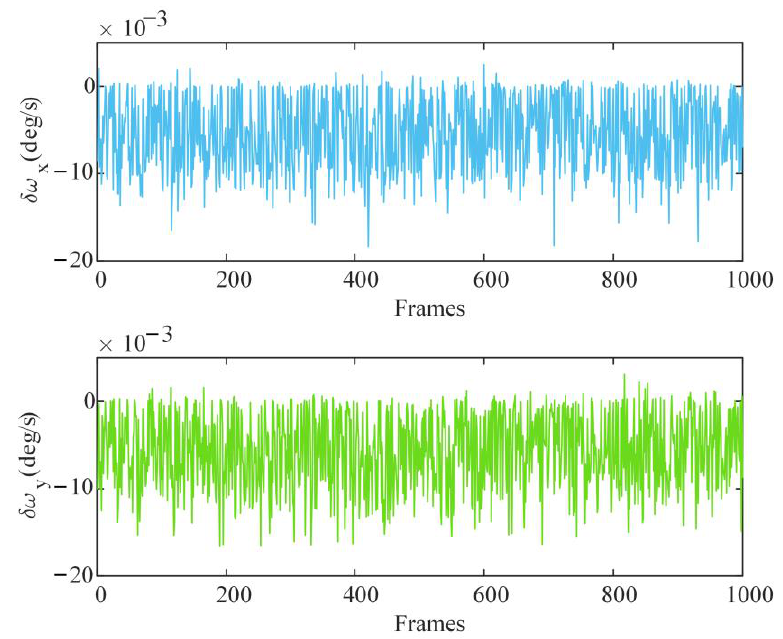
Figure 9. Velocity error distribution diagram.